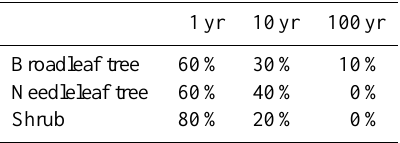
Table 3. Allocation of aboveground displaced carbon to the differ- ent wood products pools, based on the values given in McGuire et al. (2001, Table 3) but recalculated to be applied to just the above- ground carbon